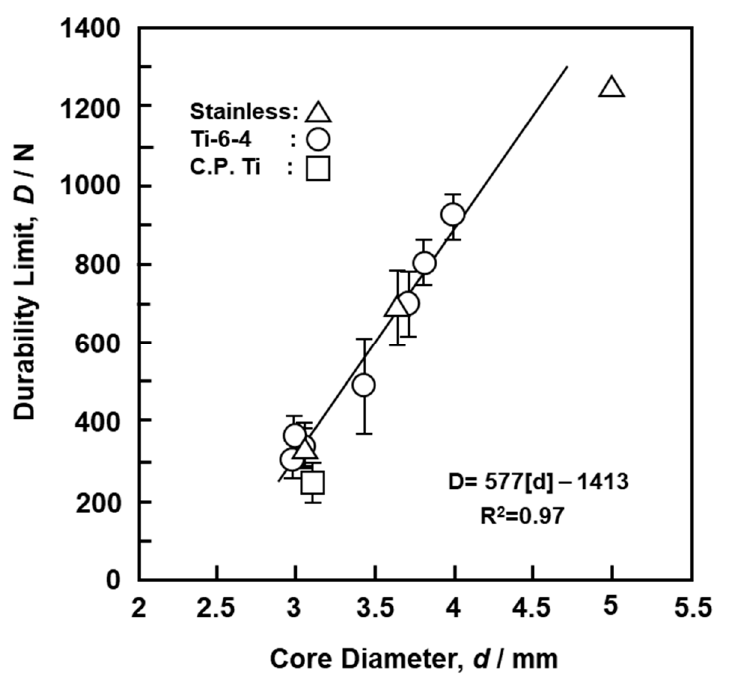
Figure 7. E ff ects of core diameter on durability limit obtained by four-point bending durability tests Figure 7. Effects of core diameter on durability limit obtained by four ‐ point bending durability tests with metallic with metallic screws.